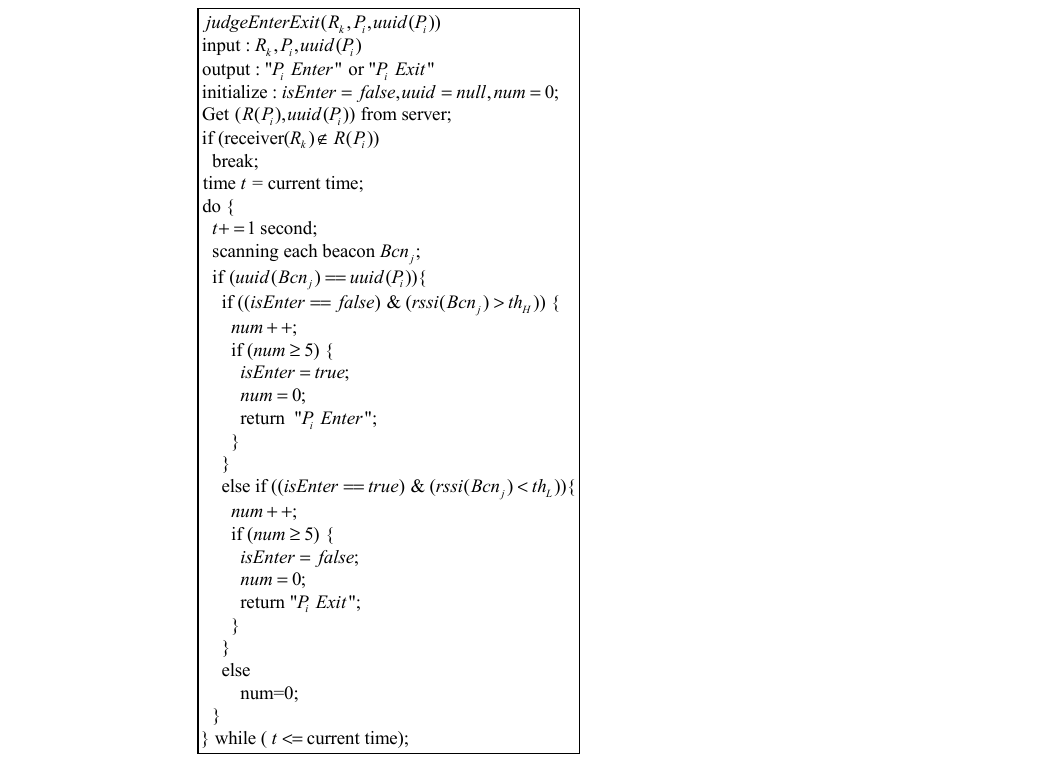
Figure 10. Algorithm to determine Beacon’s entering/leaving from a certain